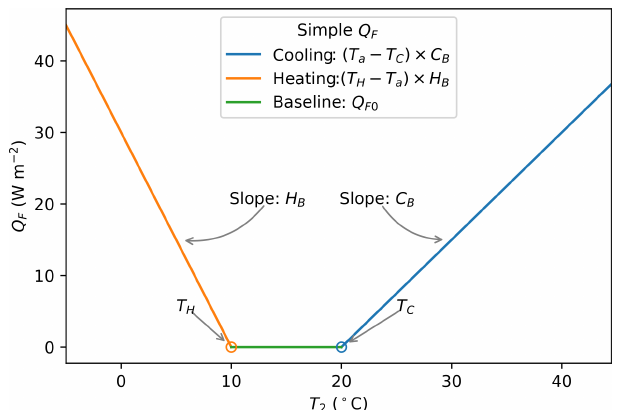
Figure 7. A simple anthropogenic heat flux ( Q F ) model as a linear function of air temperature T 2 .